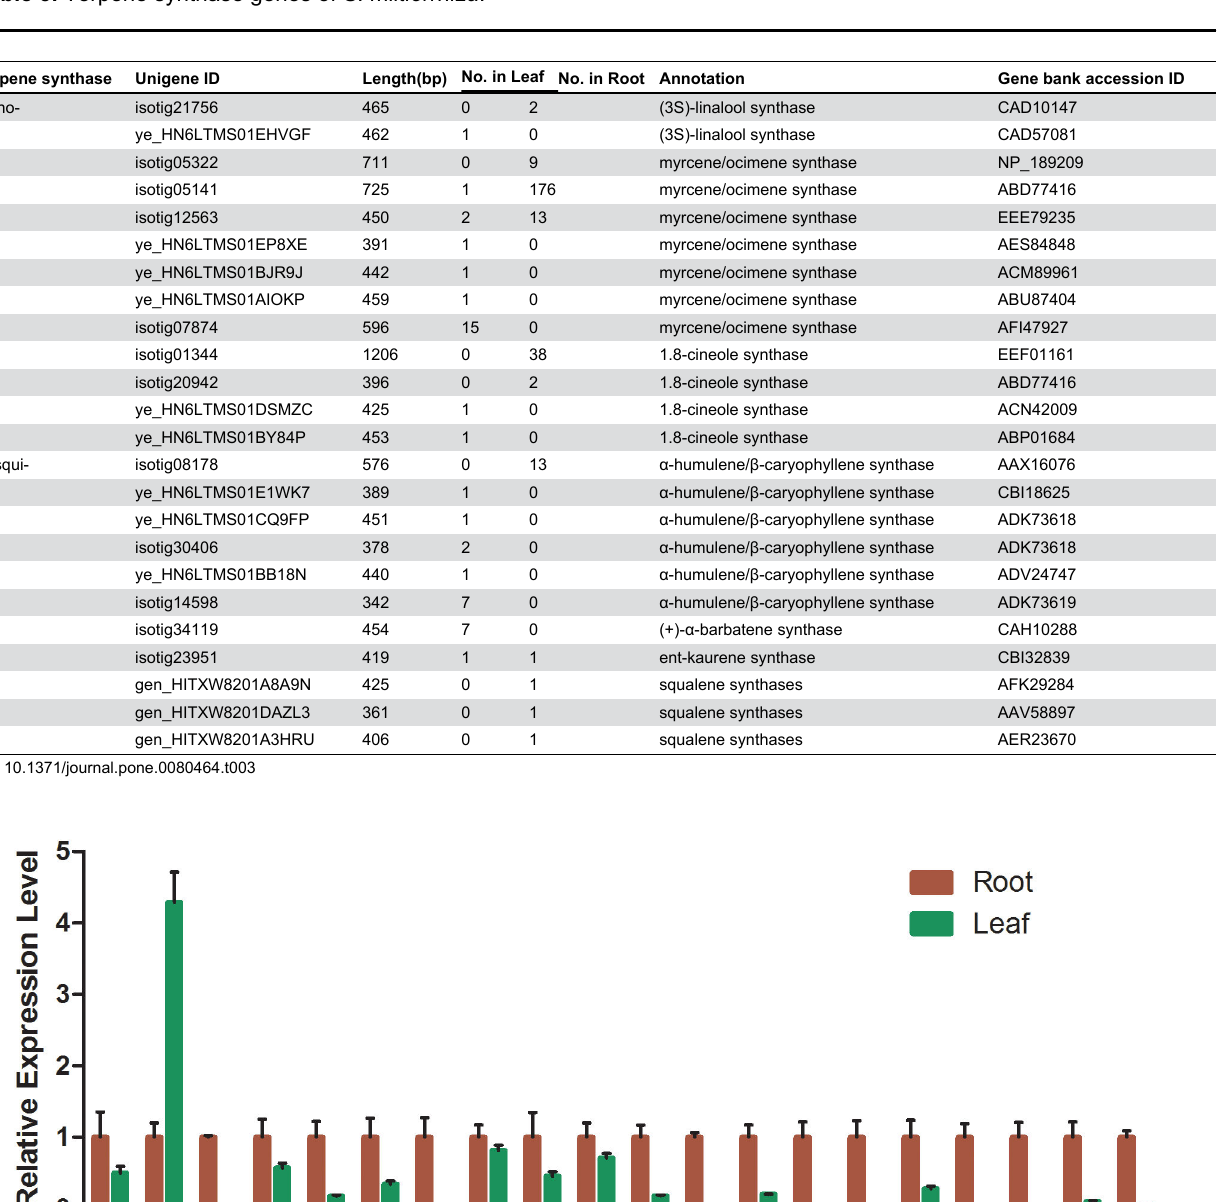
Table 3. Terpene synthase genes of S. miltiorrhiza .